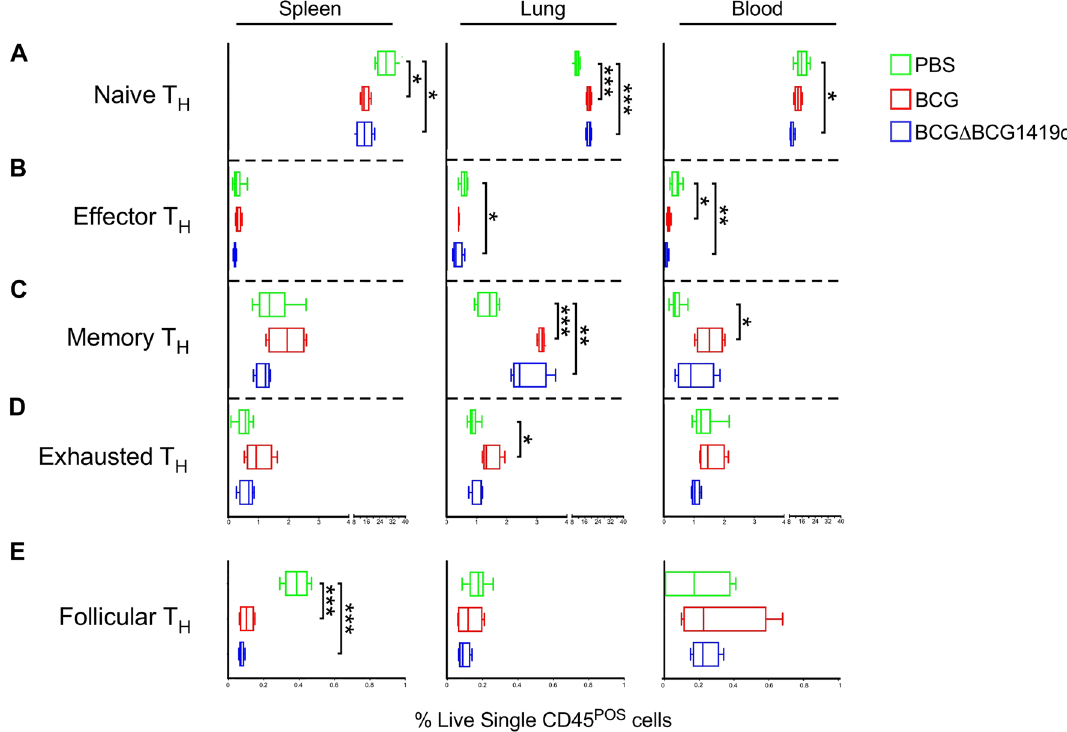
Figure 5. CD4 + T cell subset frequencies in BCG- and BCGΔBCG1419c-immunized mice. CD4 T cell (T H ) subset frequencies in BCG- and BCGΔBCG1419c-immunized mice, as well as PBS controls, were measured in the spleen, lung and blood, based on their expression of CD62L, CD44, PD1 and CXCR5 (naïve, CD62L HI CD44 LO ; effector, CD62L LO CD44 HI ; memory, CD62L HI CD44 HI ; exhausted, PD1 + ; follicular, CXCR5 + PD1 + ). Shown are the frequencies of ( A ) naïve T H cells, ( B ) effector T H cells, ( C ) memory T H cells, ( D ) exhausted T H cells, and ( E ) follicular T H cells in the spleen (left column), lung (middle column) and blood (right column), as gated off of live single CD45 + cells. Boxes represent data from 3 mice per group; asterisks represent a statistically significant difference between indicated rows (*p ≤ 0.05; **p ≤ 0.005; ***p ≤